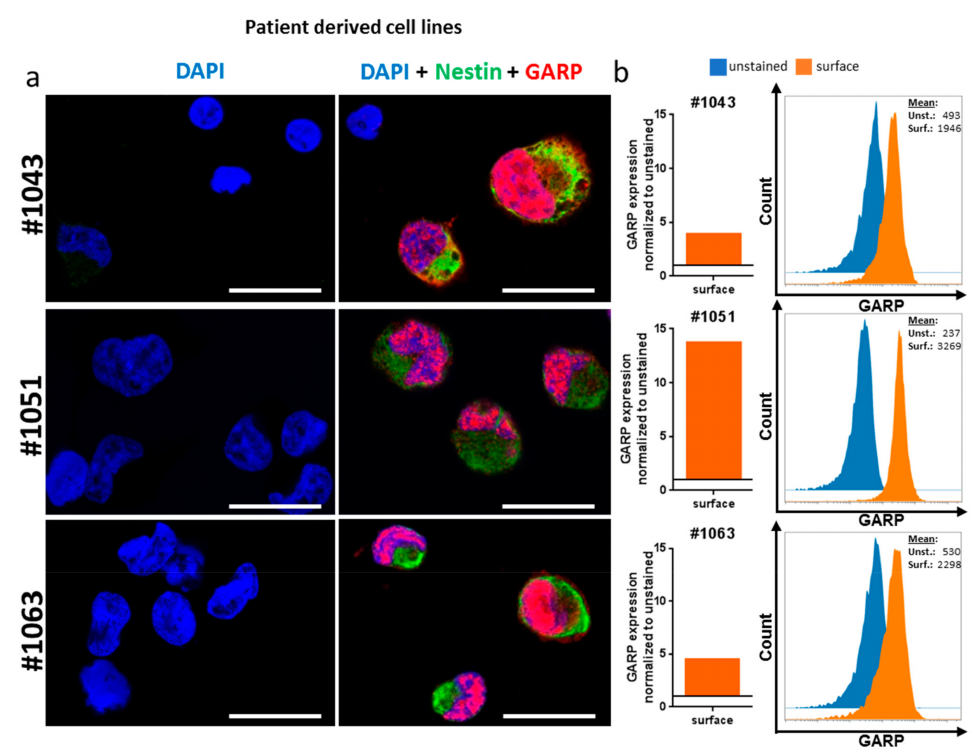
Figure 4. Flow cytometric and confocal analysis of GARP expression in patient-derived GB cell lines. ( a ) Confocal images show a strong GARP expression on the surface, intracellular (IC) and intranuclear (IN) in all tested patient-derived GB cell lines. The white bar corresponds to 20 µ m ( b ) Flow cytometric analysis of the surface expression of GARP. All three cell lines showed an expression of GARP. Due to the nature of these cells, Nestin instead of DiO was stained. Means were normalized to the unstained